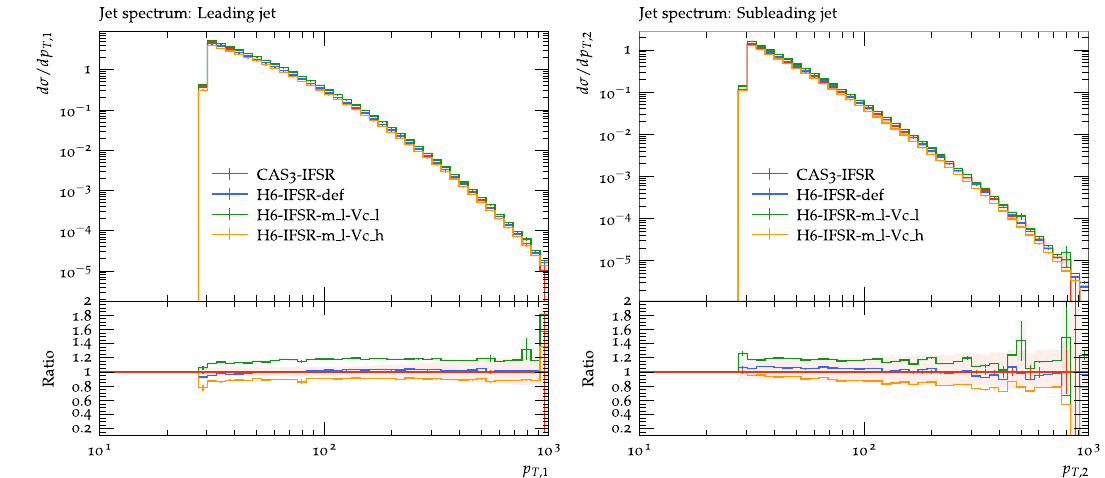
Fig. 10 ComparisonofpredictionsobtainedwithMCatNLO+CAS3andMCatNLO+H6forZ + jetobtainedwithMCatNLO.Shownarepredictions using initial and final state parton shower. The band of MCatNLO+CAS3 shows the uncertainties obtained from scale variation (as described in the text)